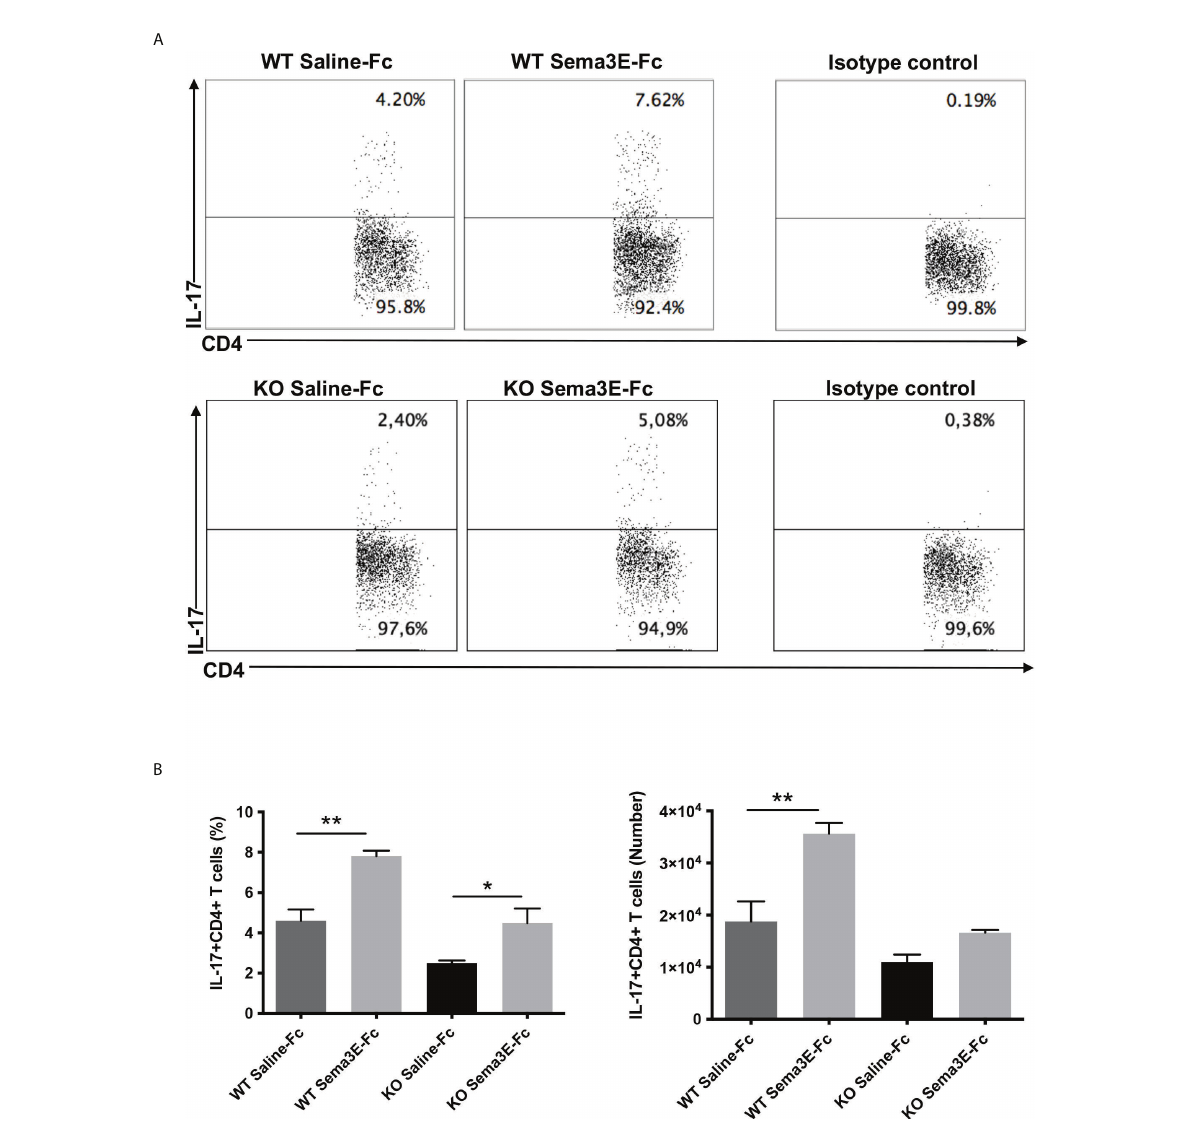
FIGURE 5 Higher IL-17 production by CD4 T cells after Sema3E-Fc treatment of Cm infected mice. CD4 + T cells isolated from the lungs of Cm infected WT and Sema3E KO mice at day 7 post-infection were stained intracellularly for IL-17. (A) Representative fl ow cytometric images and summary of fl ow cytometric analysis (B) to show the percentage and absolute number of IL-17 producing CD4 + T cells. Data are shown as mean ± SD (n = 3) and represent one of three independent experiments with similar results. * p < 0.05, ** p <